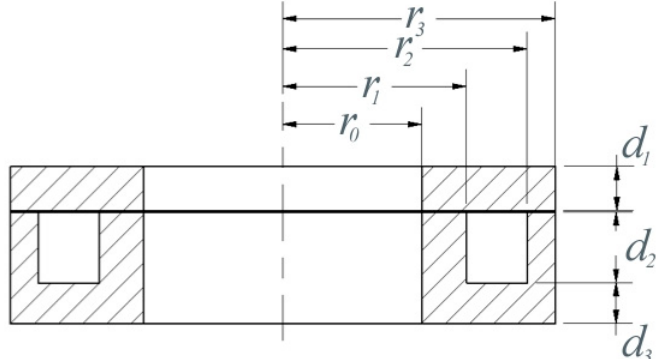
Figure 1. Axisymmetric geometry of thrust disk and stator electromagnet of an axial magnetic bearing. Only one electromagnet of the opposing pair shown (flux-carrying path in iron cross hatched).